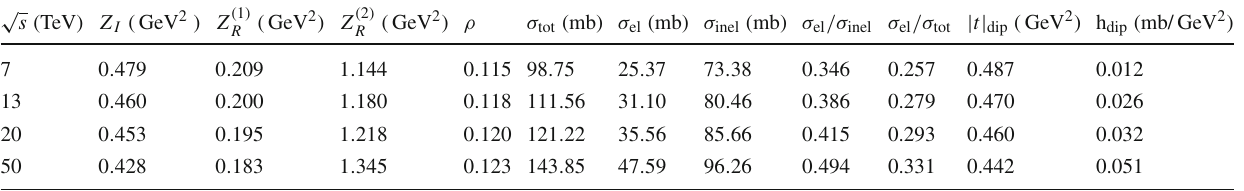
Table 6 Quantities derived from the energy dependence expressed by the interpolation equations (47). The quantities Z I , Z